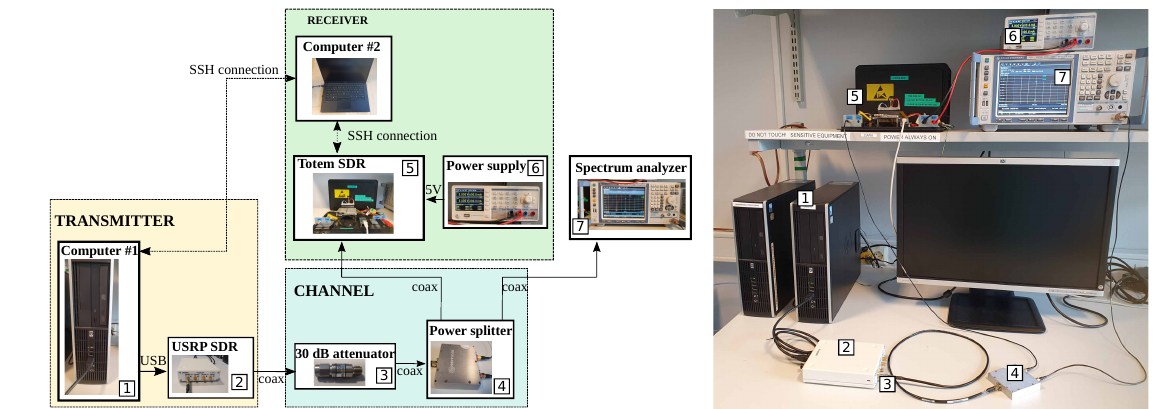
Figure 2. Flatsat setup. The USRP is used as the transmitter for test signals, and the TOTEM SDR (Software-Defined Radio) is the